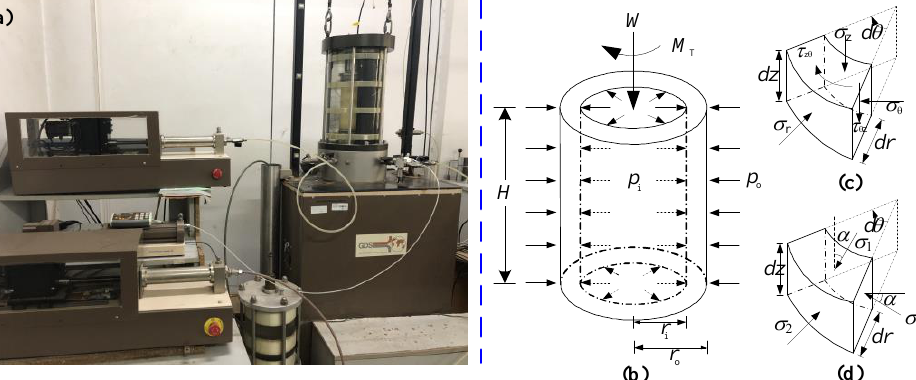
Figure 1. Particle distribution curve, photograph and scanning electron microscope picture (SEM) of tested coral sand.